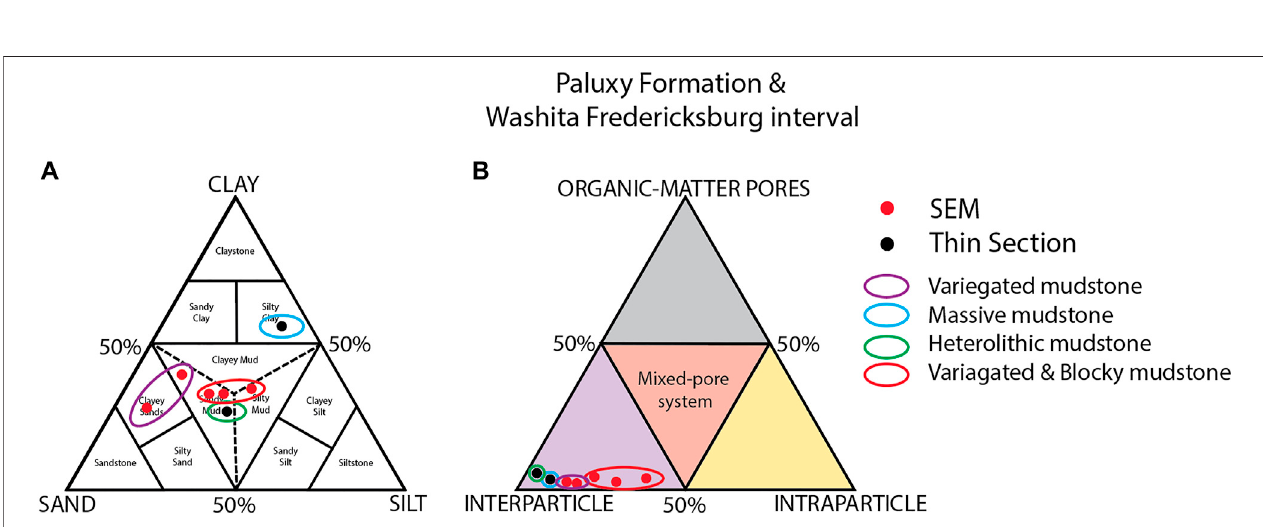
FIGURE 10 | Ternary plots showing mudrock composition and pore types in the Paluxy Formation (purple, blue, and green circle) and Washita-Fredericksburg interval. (A) Mudrock classi fi cation based on grain size and XRD mineralogical analysis. (B) Pore system analysis from petrographic analysis of mudstone.